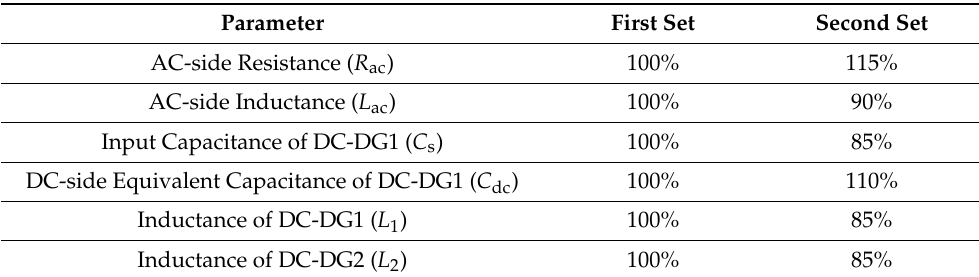
Table 4. Two different sets of MG parameters.